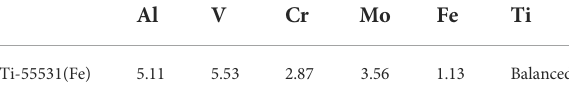
TABLE 1 Chemical composition of Ti-55531(Fe) powders used for SLM process